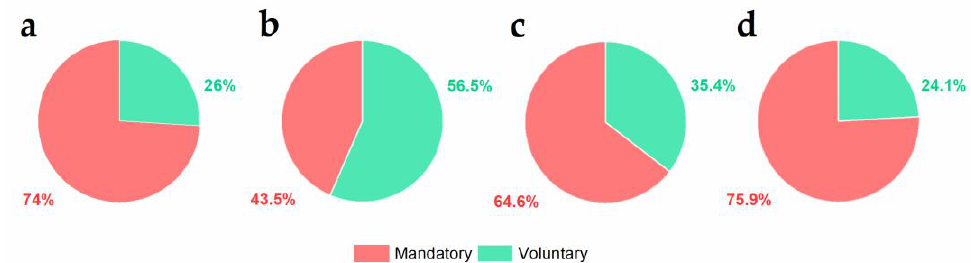
Figure 3. Share of individual answers to the surveyed groups on the Environmental Product Declaration: ( a ) investors, ( b ) architects, ( c ) contractors, ( d ) sellers of construction products.